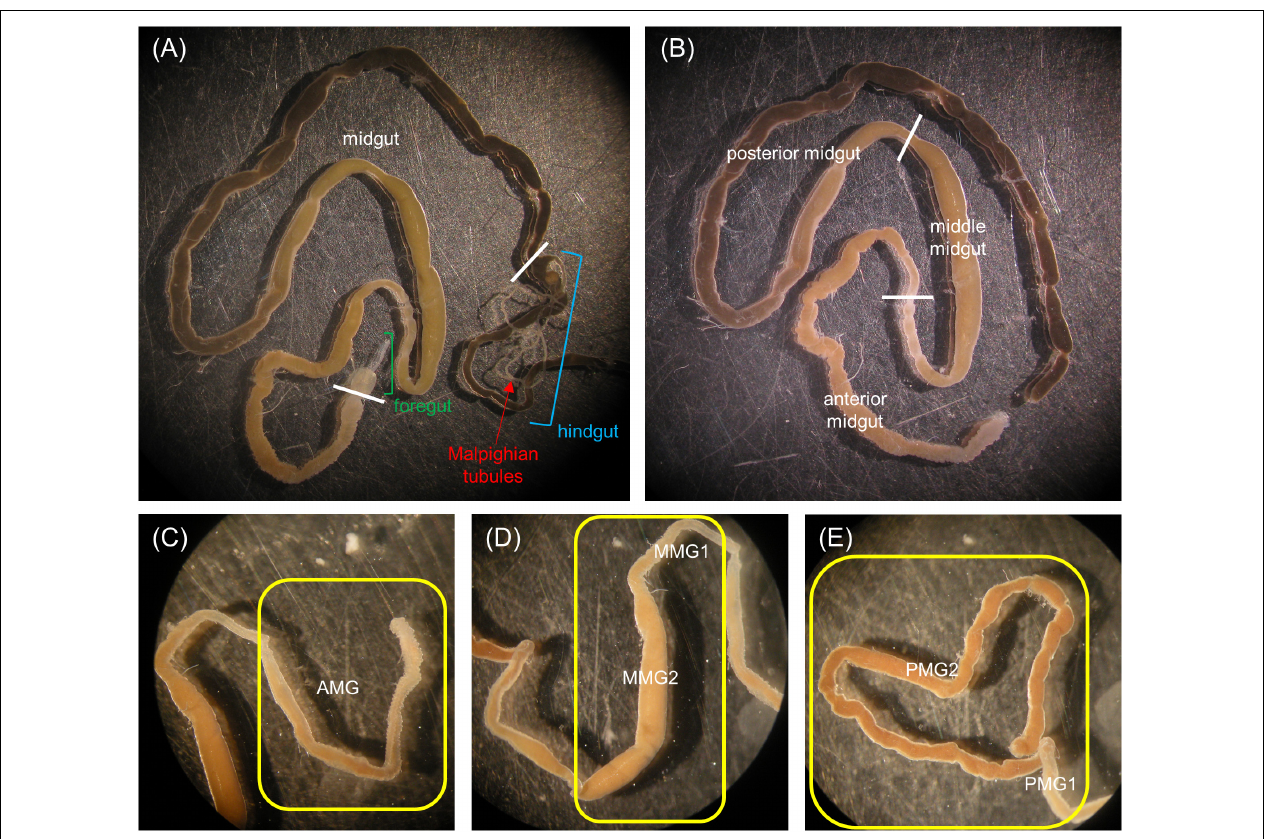
FIGURE 1 | Anatomy of the alimentary canal of H. illucens larvae and definition of the midgut regions. The short foregut is followed by a very long midgut; the beginning of the hindgut is identifiable by the insertion of Malpighian tubules, structures involved in excretion (A) . The midgut can be subdivided into three main regions: anterior, middle, and posterior (B) . In (C–E) details of each midgut region are reported. Anterior midgut (AMG) (C) ; middle midgut (D) in which a first narrow and short tract (MMG1) is followed by a segment with a larger diameter (MMG2); posterior midgut (E) in which two tracts are recognizable, a first short part (PMG1) and a second tract darker in color